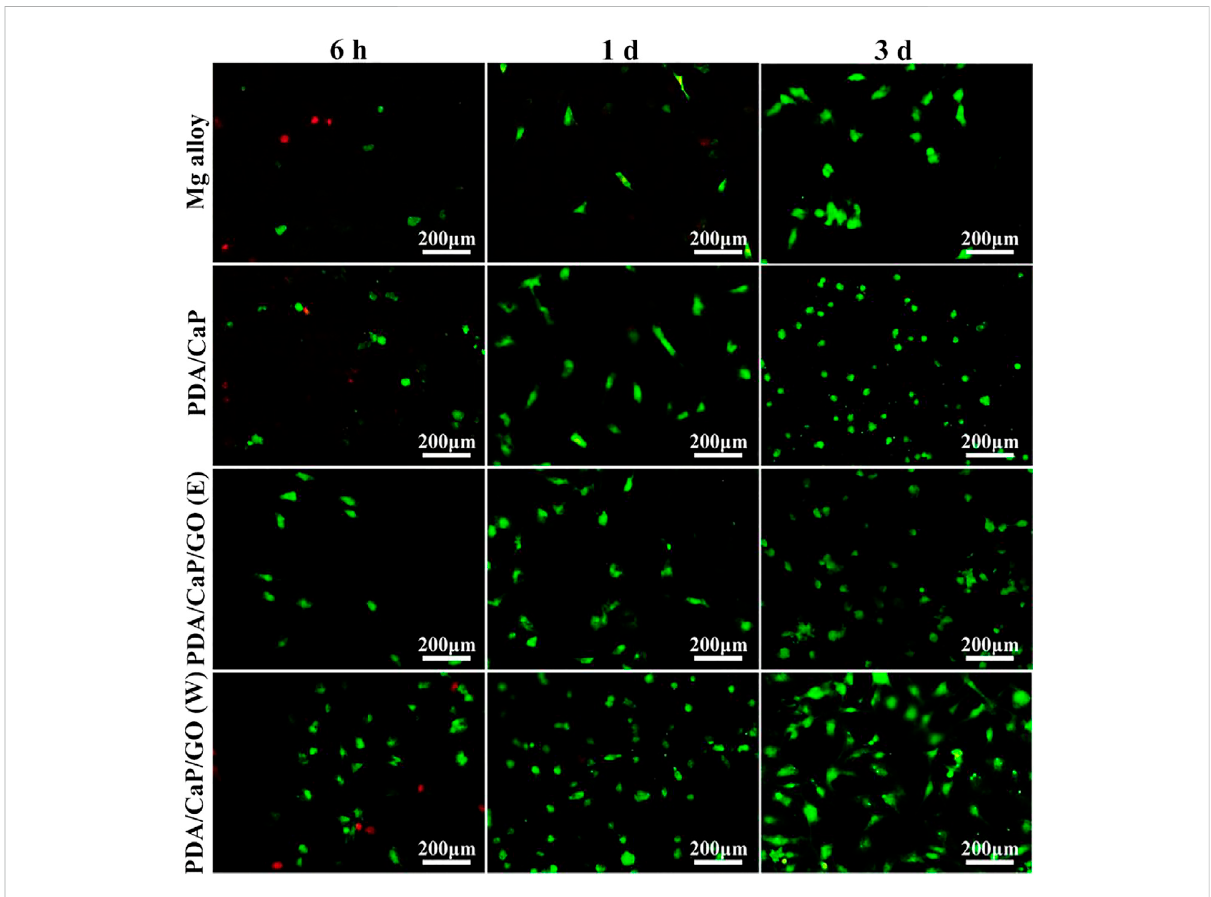
FIGURE 3 Fluorescence images of live/dead staining of cells after cultured on the different samples. Reprinted with permission from reference (Dong et al., 2022b),